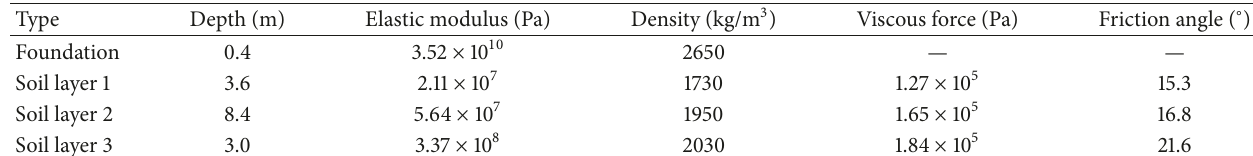
Table 1: Material parameters of the soil and foundation model.